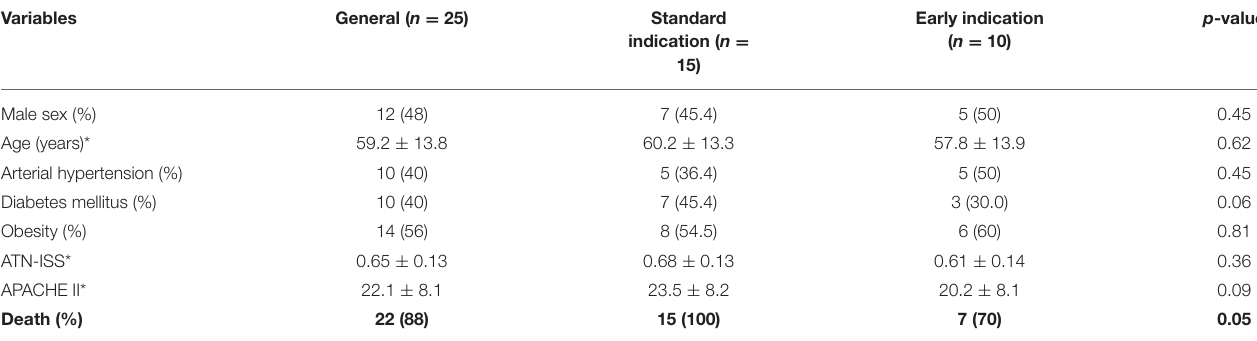
TABLE 7 | Clinical and laboratory characteristics in patients admitted in ICU according to renal acute support indication.